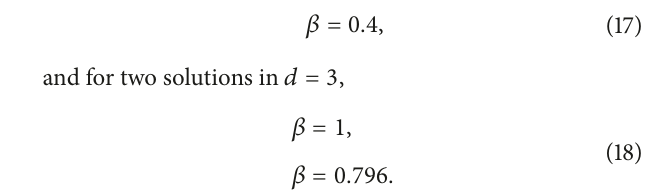
Figure 1: Dyson–Schwinger equation for the ghost